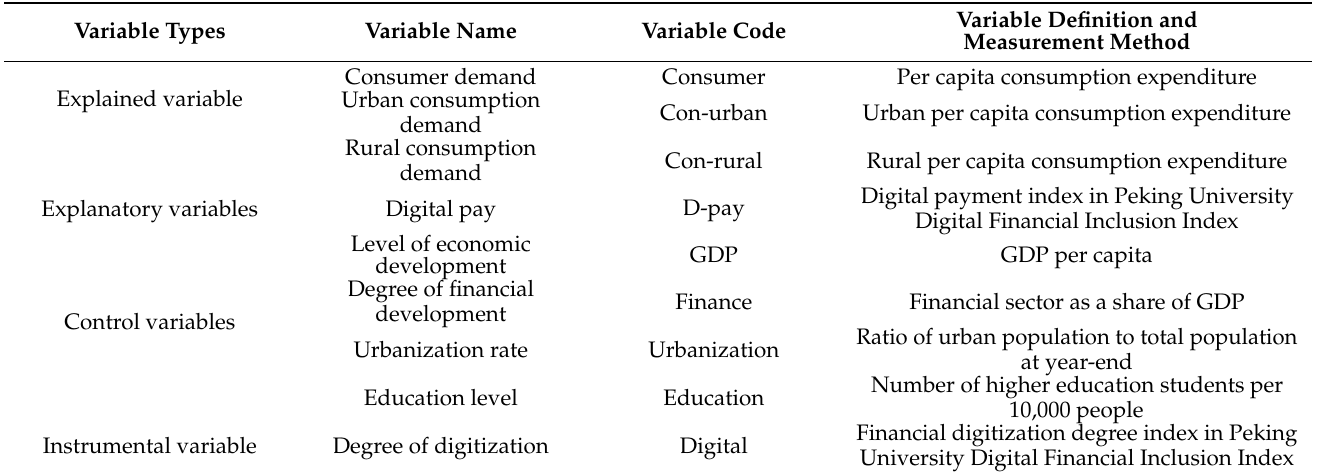
Table 1. Variable definition